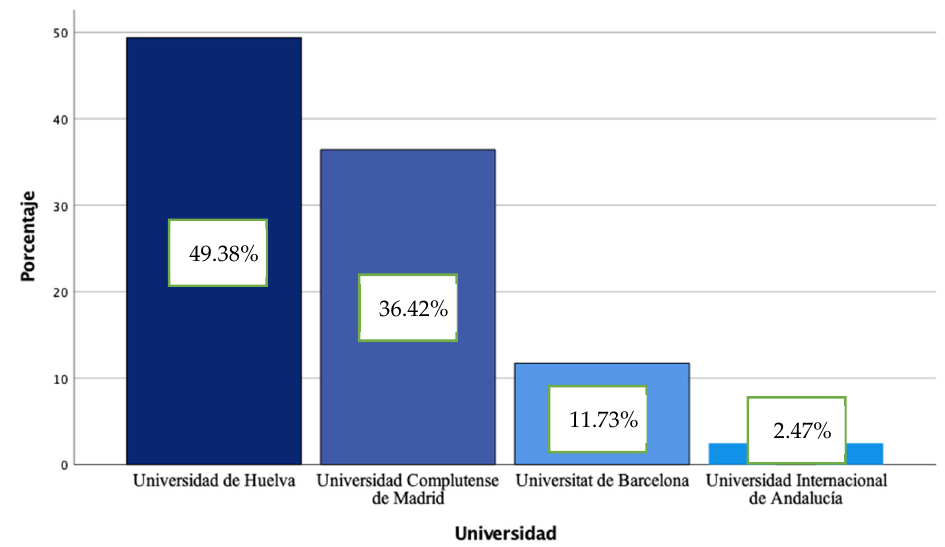
Figure 1. Percentage of students by participating universities.